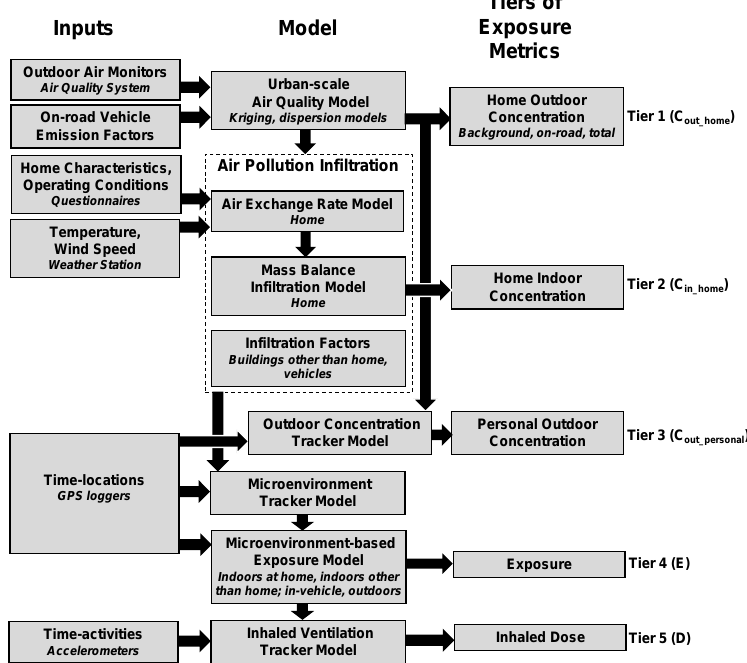
Figure 1. Conceptual model of Exposure Model for Individuals (EMI) to predict five tiers of individual-level exposure metrics for ambient fine particulate matter (PM 2.5 ), elemental carbon (EC), nitrogen oxides (NO x ), and carbon monoxide (CO). Tiers 1–2 (C out_home —outdoor concentration; C in_home —indoor concentration) are related to homes, and Tiers 3–5 (C out_personal —personal outdoor concentration, E—exposure, D—inhaled dose) are related to participants.